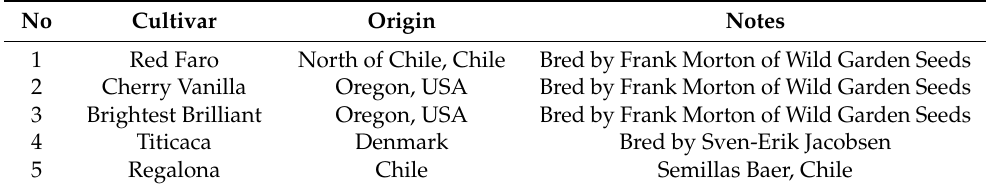
Table 1. Origin of the quinoa cultivars used in the field experiment.